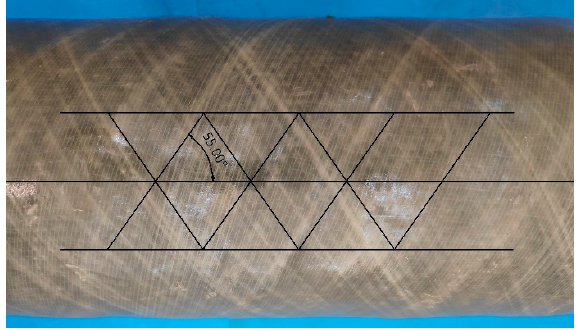
Figure 1. Alignment of fibers in filament-wound pipes.